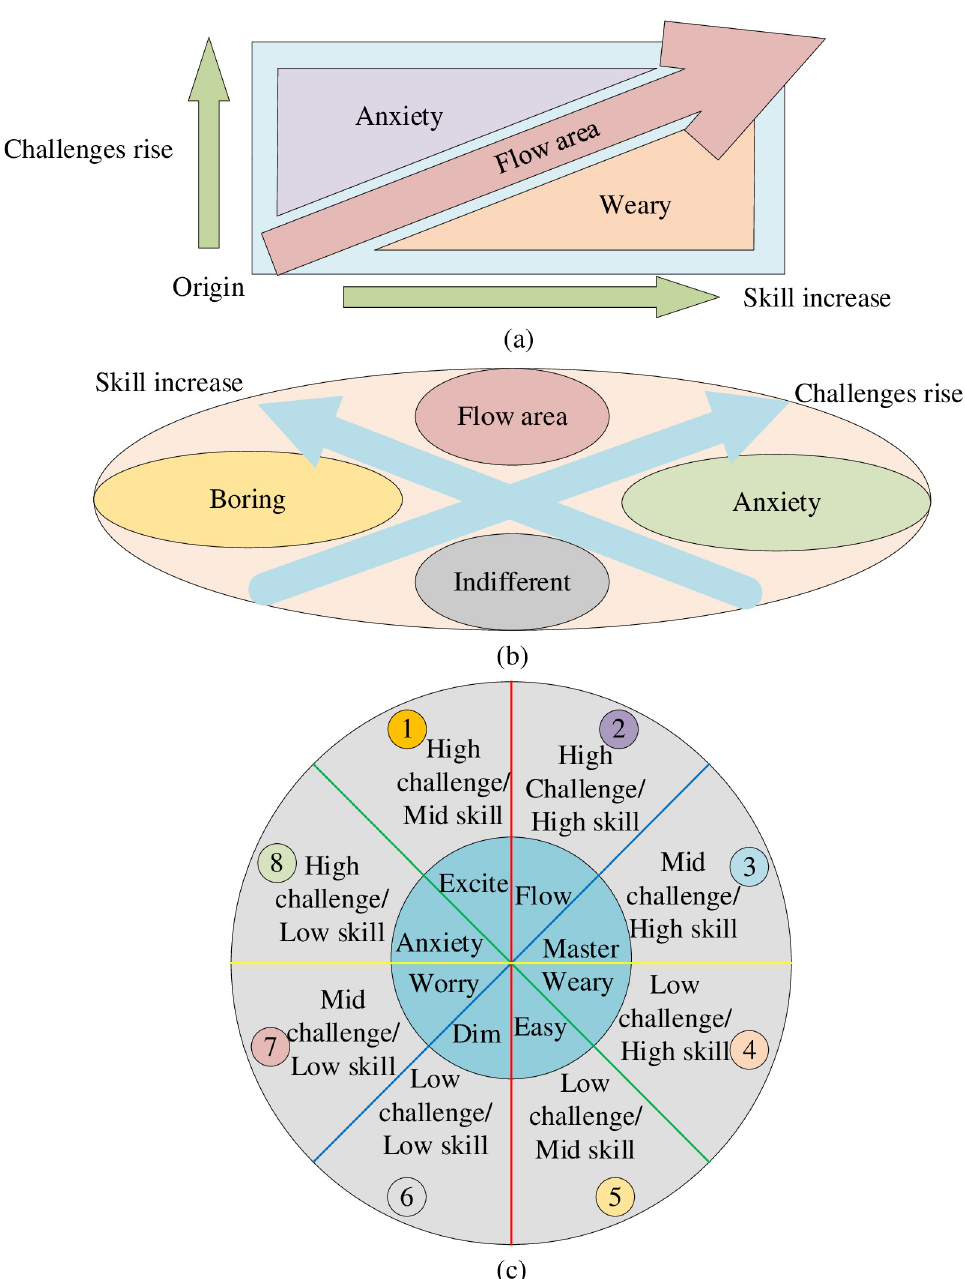
Fig 1. Flow Theory framework of Immersive Experience (a: three-channel, b: four-channel, c: eight-channel). https://doi.org/10.1371/journal.pone.0268007.g001 supervised algorithm for training Shallow Neural Network (SNN). Generally, the DNN model is a three-layer system. The following is a whole DL NN training process. Firstly, the six-dimensional vector is imported. Two hidden layers output a two-dimensional vector: the probability that the input samples belong to one of the two categories. Before unsuper- vised learning, the system initializes the network parameters randomly. It optimizes the parameters through layer-wise training to get them close to data features. Eventually, the